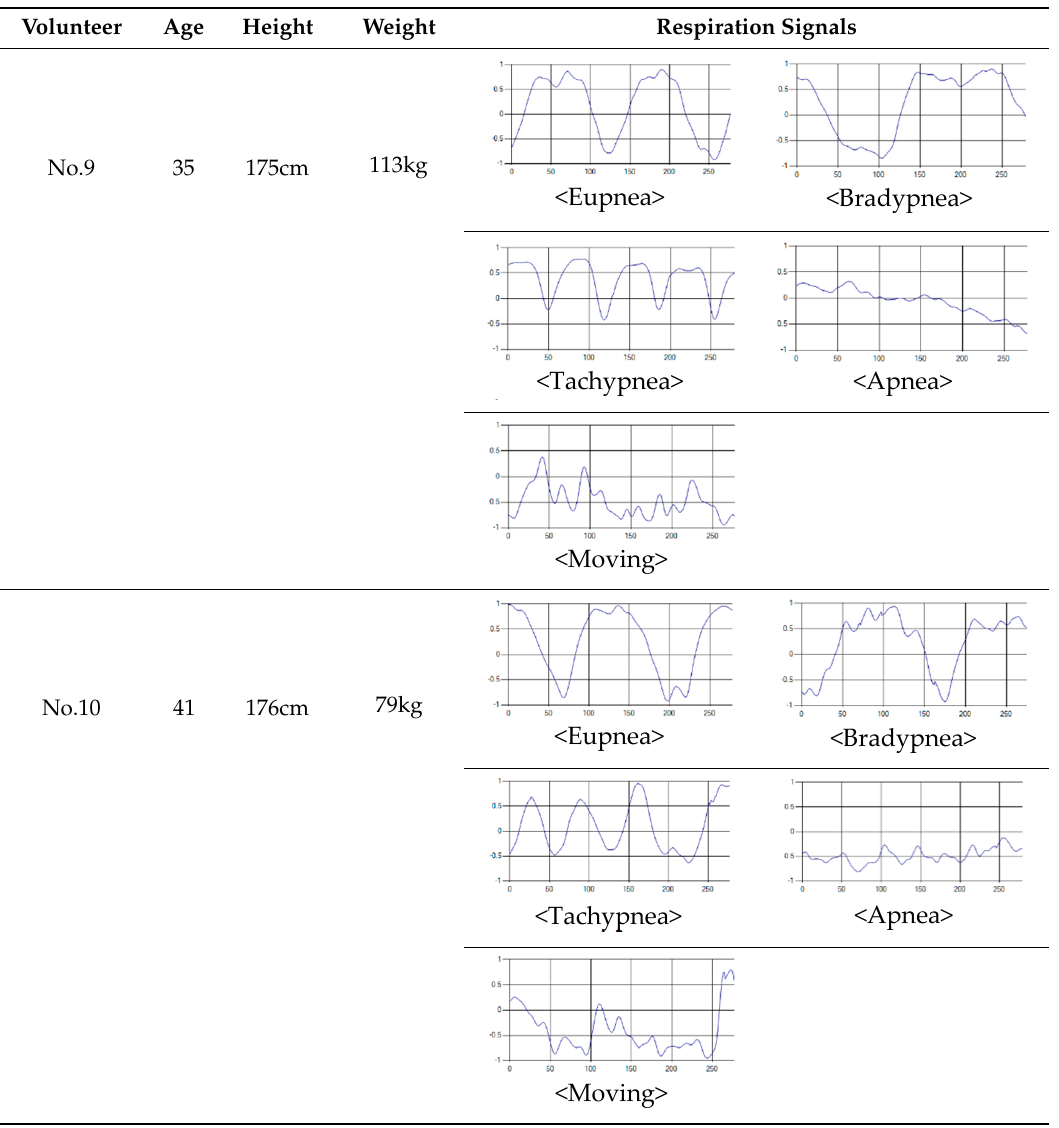
Table 8. To evaluate the performance of the proposed 1-D CNN model, each parameter value is selected from the optimal parameter range.